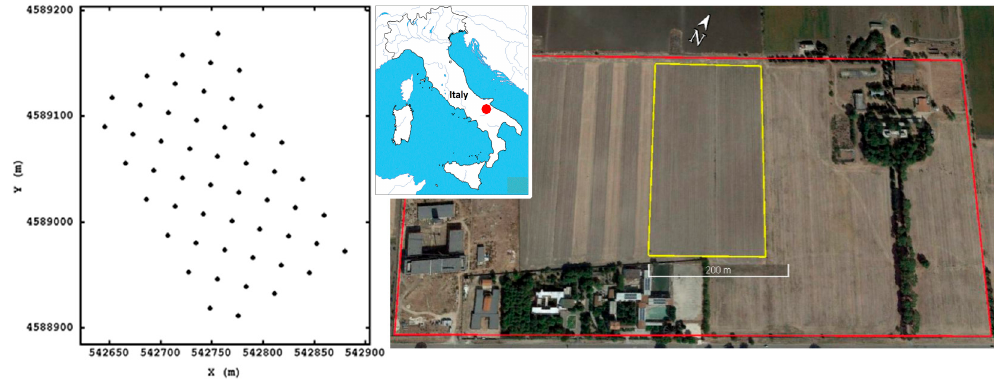
Figure1. Geographicallocation, viewof“Menichella”farm, andschemeofthefifty-twosamplingpoints. Fifty-two geo-referenced sampling points, located at the nodes of a regular grid (175 m × 250 m) with a mesh of 20 m × 40 m, were considered in this investigation (Figure 1). The amount of observations was checked to ensure a su ffi cient coverage of the study area, i.e., a number of pairs for each distance class larger than the minimum required for an e ff ective spatial analysis, as reported by Myers [36] (minimum threshold equal to 25 pairs; actual pairs observed ranging between 66 and 239). At each selected point, the wheat yield and some physical, hydraulic and chemical soil properties (e.g., soil texture, dry bulk density, saturated hydraulic conductivity, total organic carbon content)